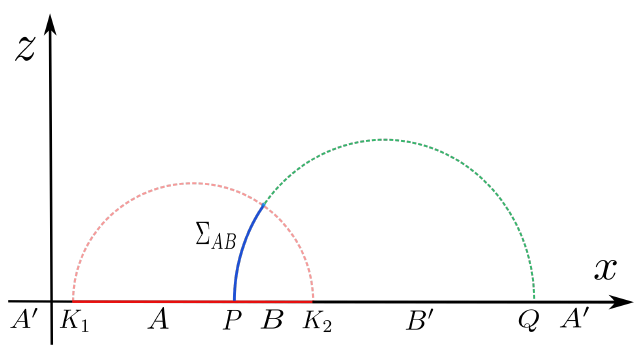
Figure 3: The x coordinates for points K ( A ) = s ( B ) which is dual to the EWCS Σ by s AA (cid:48) BB (cid:48)